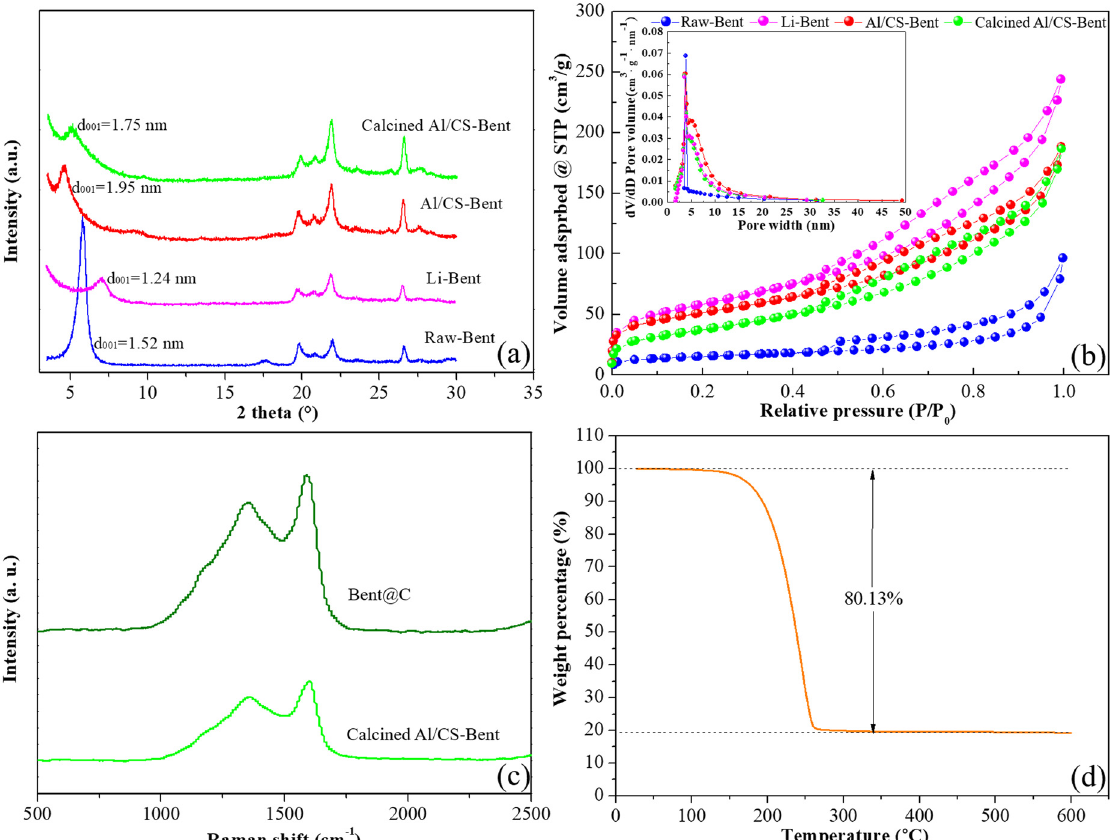
Figure 3: ( a ) XRD patterns; ( b ) nitrogen adsorption - desorption isotherms and pore size distributions ( inset ) of raw and modi fi ed bentonite; ( c ) Raman spectra of Bent@C and calcined Al/CS - Bent. ( d ) TG curve of